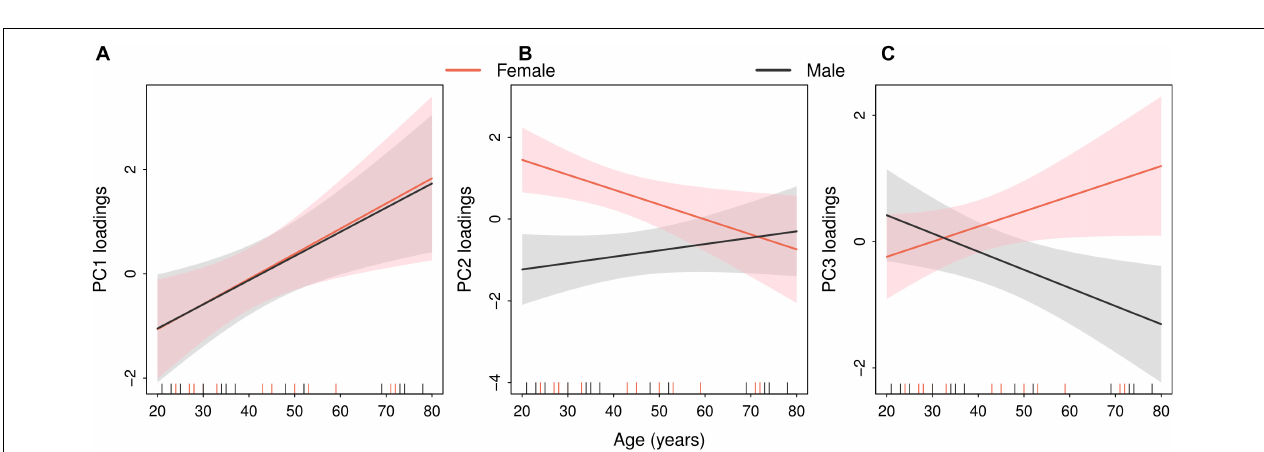
FIGURE 6 | Sex-specific linear relations between age and Coretemp parameters from composite cosinor model. Estimated regression lines (solid lines) with 90% confidence bands (shaded areas) in males (black) or females (red). The vertical dashes in the abscissa indicate the age of each of the 33 subjects in ST2. (A) Coretemp mesor and (B) Coretemp amplitude.